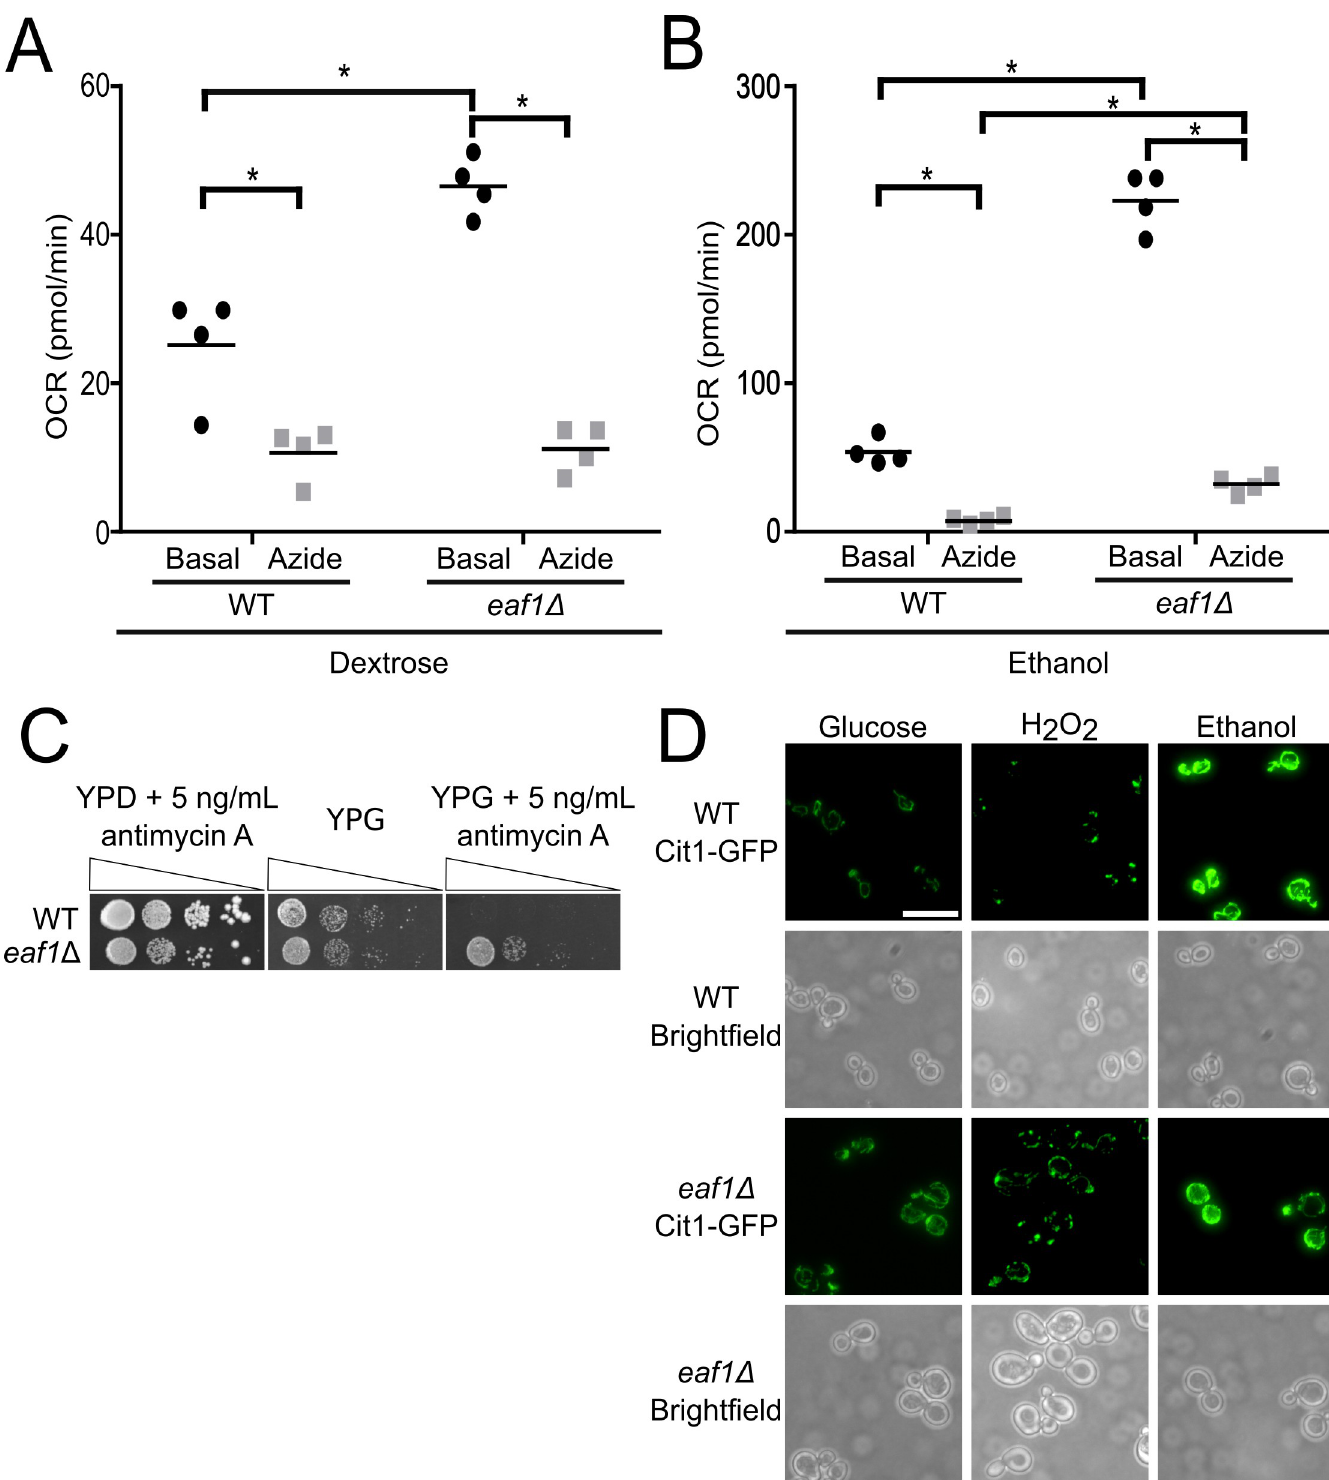
Fig 4. eaf1 Δ mutants have functional mitochondria and are able to respond to biogenesis and fission signals. The oxygen consumption rate (OCR) of either WT or eaf1 Δ cells was measured using the Seahorse Extracellular Flux Analyzer. After basal measurements, sodium azide was injected into the wells to shut off mitochondrial oxygen consumption and an additional set of measurements were taken. This was performed for (A) cells grown in dextrose media and (B) for cells grown in ethanol media for four biological replicates. ANOVA analysis was performed with a Tukey’s multiple comparison test comparing pairs of means. � = p < 0.05. Horizontal bars